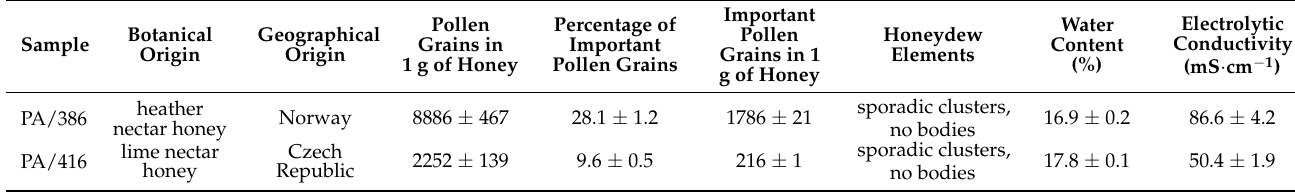
Table 1. Description of the honey